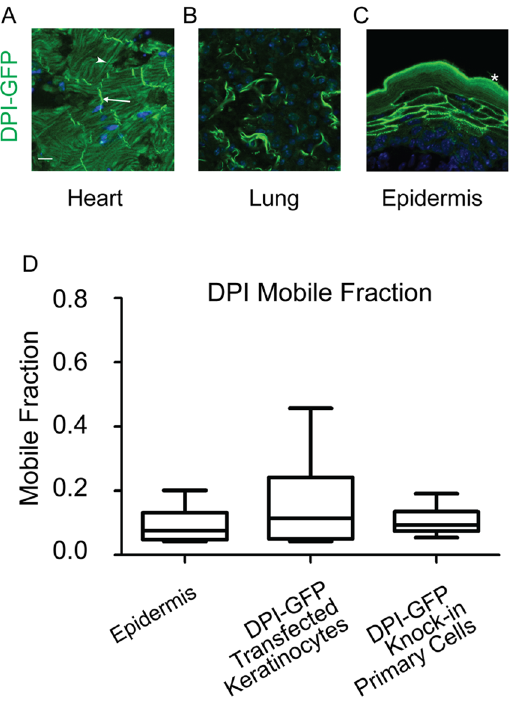
Figure 4. DPI-GFP is stable at desmosomes in both epidermis and in cultured keratinocytes. A–C) Tissue sections from the adult BAC transgenic DPI-GFP mouse. DNA is stained in blue. Scale bar 10 m m. A) DPI-GFP localization in heart tissue section. Note the strong bands of signal at intercalated discs (arrow). There is strong autofluorescence from thick actin bundles in cardiac muscle fibers (arrow head). B) DPI- GFP localization in lung tissue section. C) DPI-GFP localization in epidermal tissue section. Asterisk labels autofluorescence of cornified layer. D) Mobile fractions from FRAP experiments are plotted. The box represents the 25 th to 75 th percentile and the whiskers represent the 10 th and 90 th percentiles.